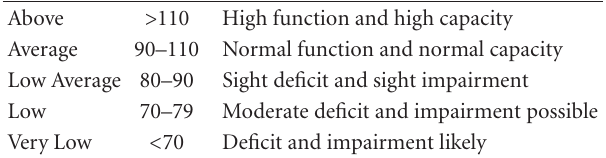
Table 1: Clinical levels of severity (CNSVS). The CNSVS [5] con- tains five degrees of clinical severity based on a database with more than 1900 subjects, aged between 8 and 90